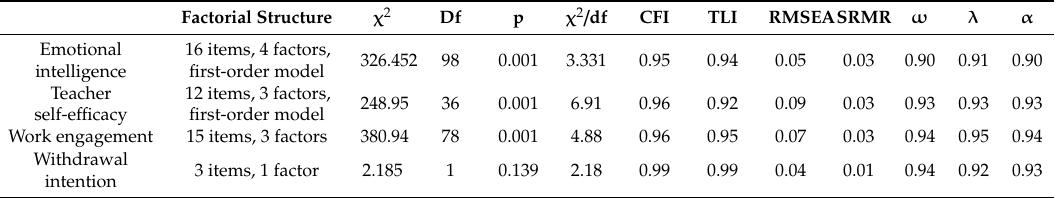
Table 1. Factorial validity of the measures.